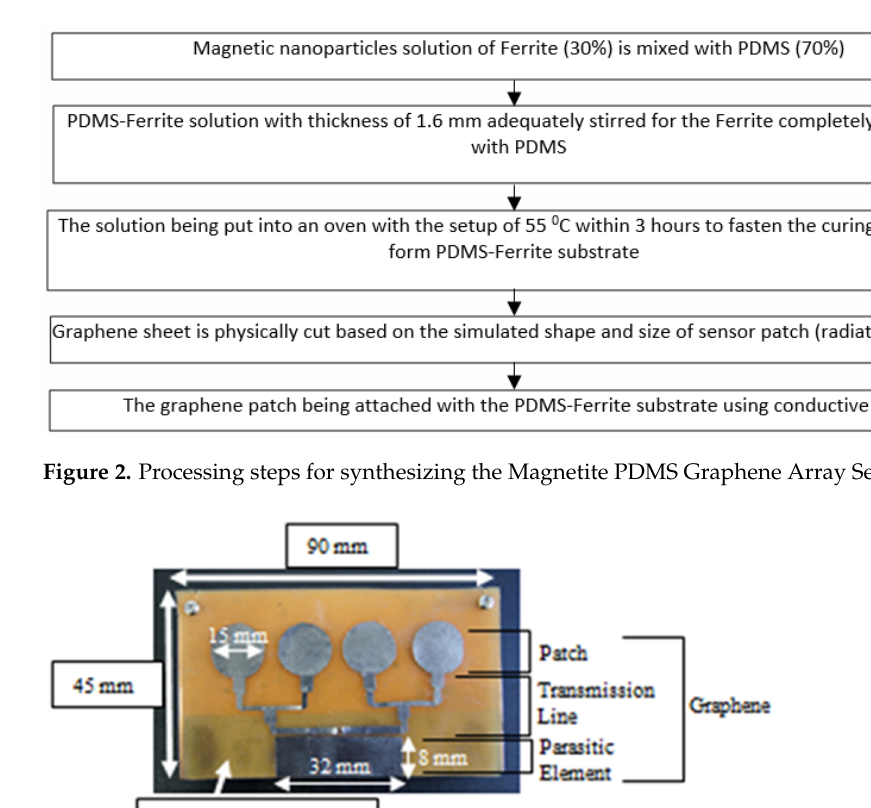
Figure 1. Simulated graphical propose sensor, ( a ) front and ( b ) back (transparent without reflector). Table 2. Geometrical Dimensions.